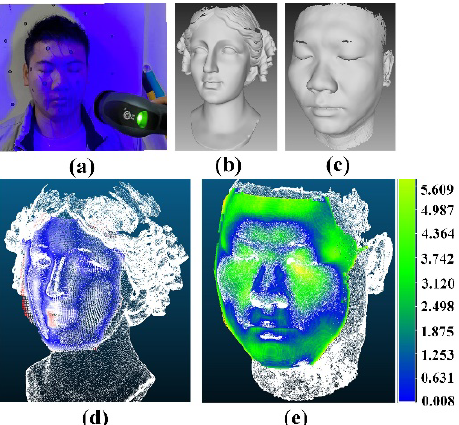
Figure 9. Three-dimensional reconstruction accuracy quantification of the proposed method using laser scanning. ( a ) Laser scanner and measuring illustration, ( b , c ) Recovered 3D face by laser scanner; ( d , e ) point cloud comparison between laser scanner and the developed method.